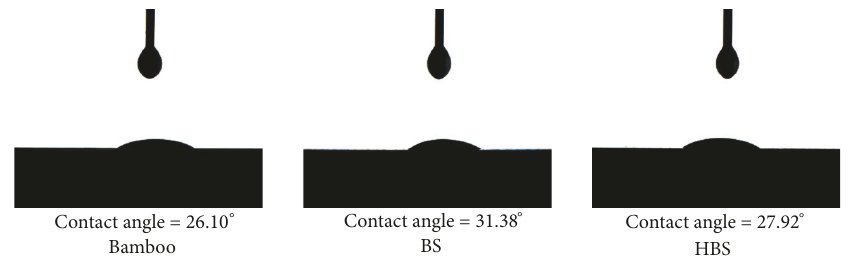
Figure 6: Contact angle of bamboo, BS, and HBS with 70% PUA drop.